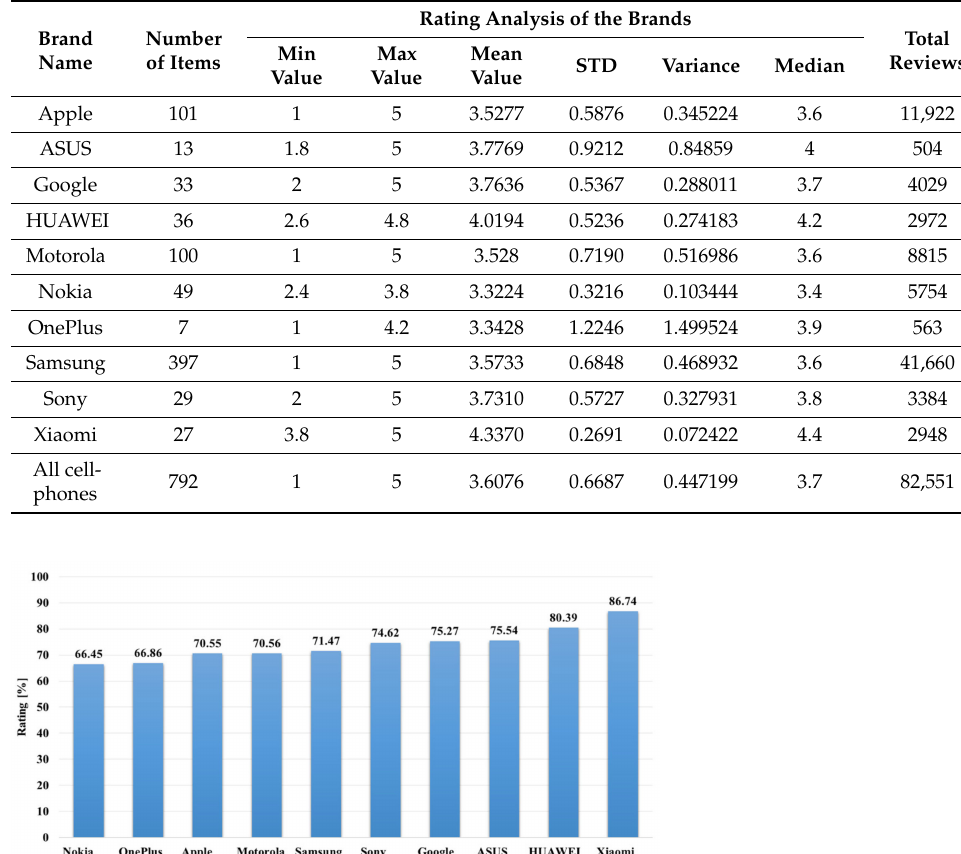
Table 5. Data analysis representation for cellphone reviews data.